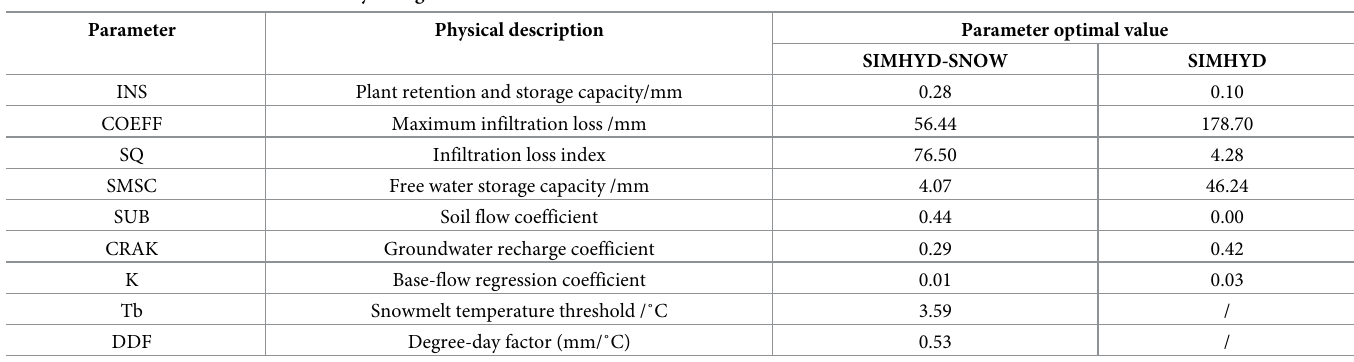
Table 2. Parameters of SIMHYD-SNOW hydrological